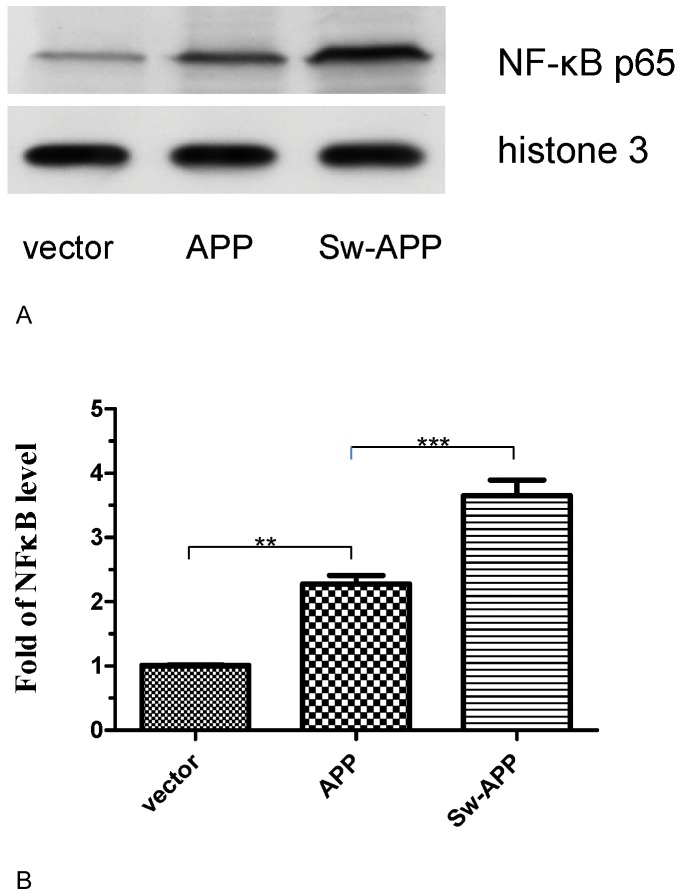
Western blot for nuclear factor-kappa B (NF-κB) activation.
A. SH-SY5Ycells transfected with the Swedish-APP mutant (Sw-APP) had significantly higher level of nuclear NF-κB p65 than cells transfected with wild-type APP (APP), which had higher level of nuclear NF-κB p65 than cells transfected with empty-vector (vector). The control nuclear protein was histone 3. B Image J and statistical analysis confirmed statistically significant difference in the level of NF-κB activation. Sw-APP transfected SH-SY5Ycells under greatest Aβ neurotoxicity had the highest level of nuclear NF-κB p65 more than that of wt-APP transfected cells (p<0.0001), which had higher level of NF-κB p65 than empty-vector transfected cells without Aβ neurotoxicity (p<0.001). Results shown were mean values from 3 independent cultures, and compared by one-way ANOVA using Newman-Keuls multiple comparison test.